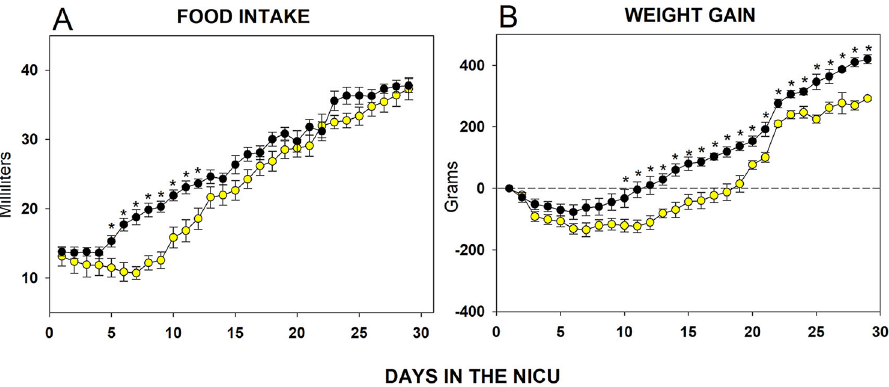
Figure 1. ( A ) Daily milk consumption in both study groups. Infants allocated to the experimental study group tolerated more milliliters in the initial days post-birth compared with subjects in the control group. The difference between daily milk consumption between study groups was statistically significant (* p < 0·001). ( B ) Body weight gain among infants included in each study group, there is a numerical difference since the first 7 days, but this difference is statistically significant 10 days after birth (* p < 0·001). White circles (open circle) represent the control group (CBL), while black circles (filled circle) represent the experimental group